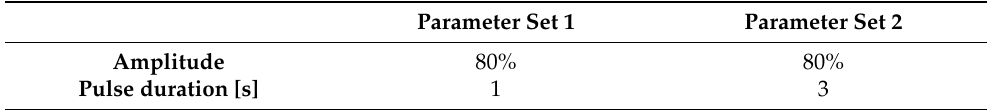
Table 6. Parameter combinations used during the pulse thermography measurements. The value of the amplitude is kept constant at 8 in order to ensure an adequate heating intensity.